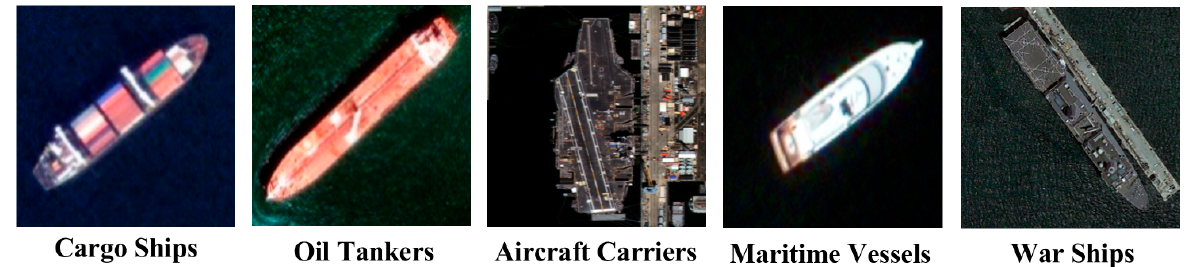
Figure 7. Labeling images for each ship class in the SDS dataset.